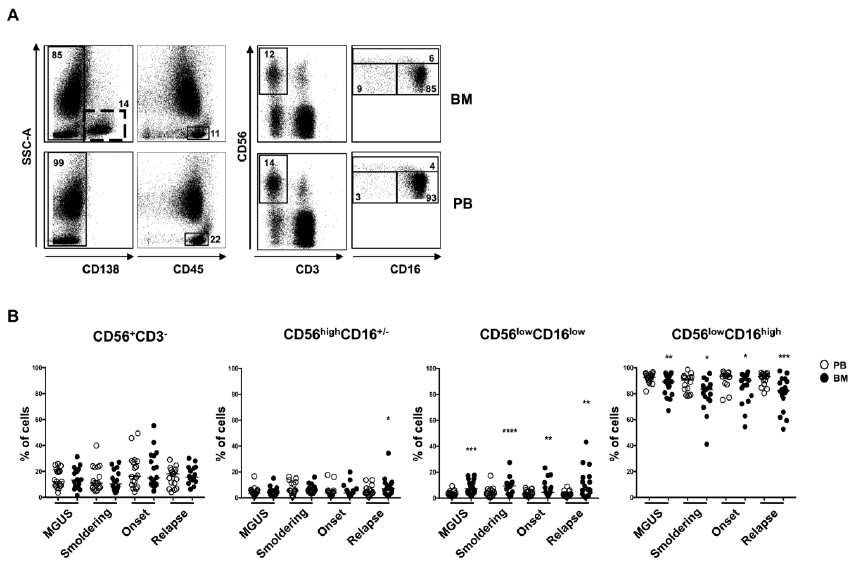
Figure 1. Natural Killer (NK) cell subset distribution in bone marrow (BM) and peripheral blood (PB) of multiple myeloma (MM) patients at different states of the disease. Representative dot plots of NK cells derived from PB and BM of MM patient after CD138 + cell gate exclusion, by gating on CD45 + CD56 + CD3 − cells were shown. NK cell subsets were analyzed considering the expression levels of CD56 and CD16 ( A ). Percentage of total NK cells and NK cell subsets in PB (white circle) and BM (black circle) of MM patients at different states of the disease was shown ( B ) (MGUS, n = 19; Smoldering, n = 18; Onset, n = 18; Relapse, n = 17) **** p < 0.0001; *** p < 0.001; ** p < 0.01; * p < 0.05. The most significant differences in the NK cell distribution between PB e BM were mainly observed for the CD56 low CD16 low subset in the monoclonal gammopathy of undetermined significance (MGUS) and Smoldering